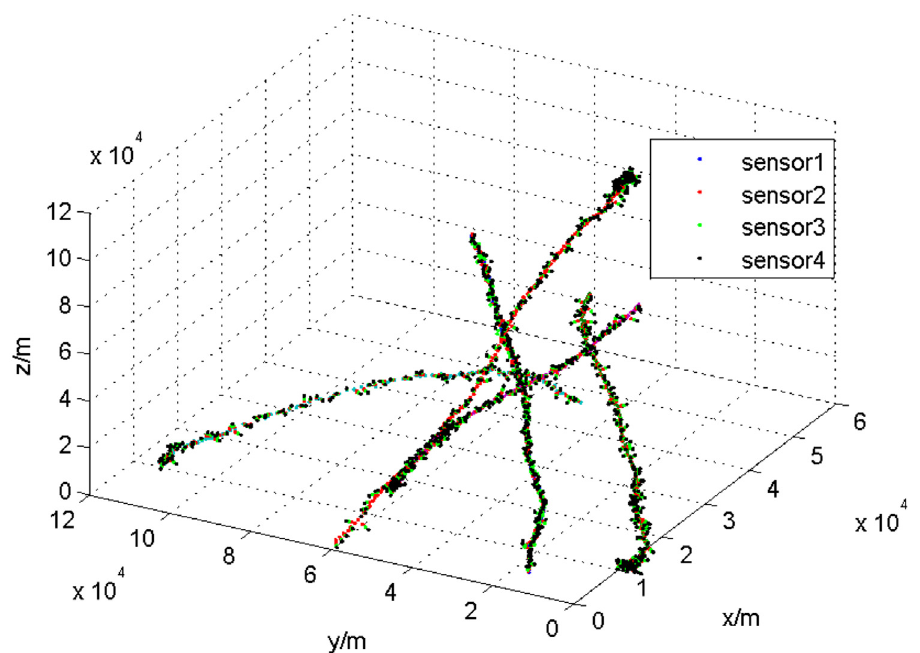
Fig 2. The observational data from local